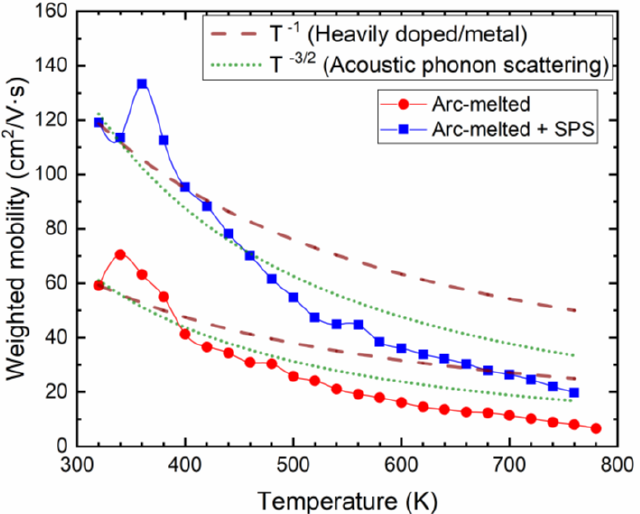
Figure 8. Temperature dependence of the weighted mobility calculated for the arc-melted SnTe and the arc-melted and sintered (SPS) SnTe. the arc-melted and sintered (SPS)